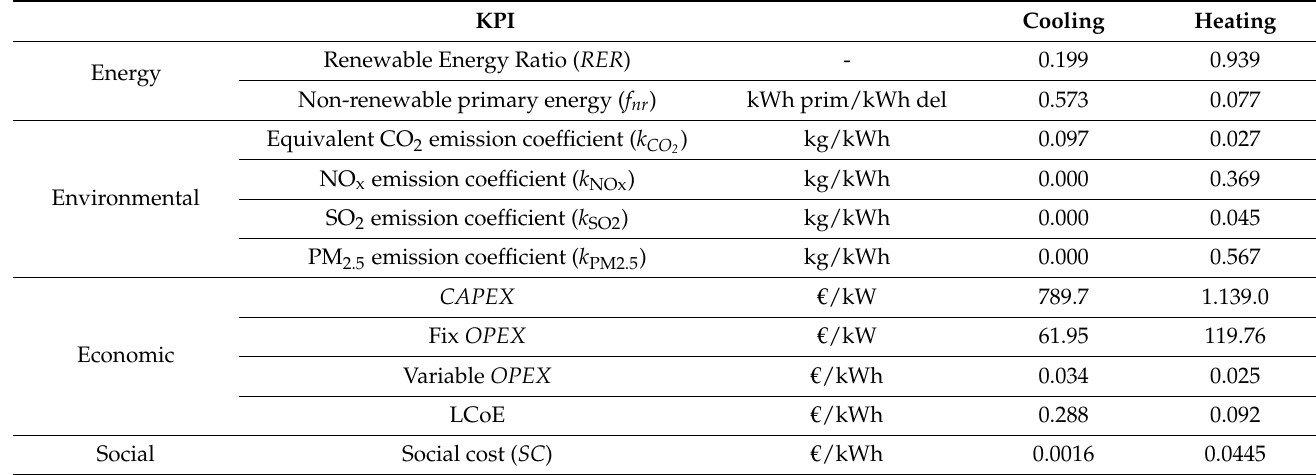
Table 2. Olot DHC KPI